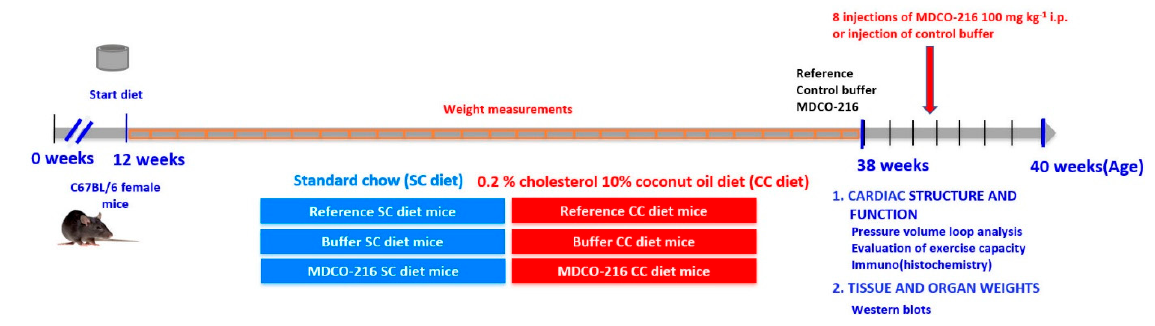
Figure 1. Schematic representation of the study desi.